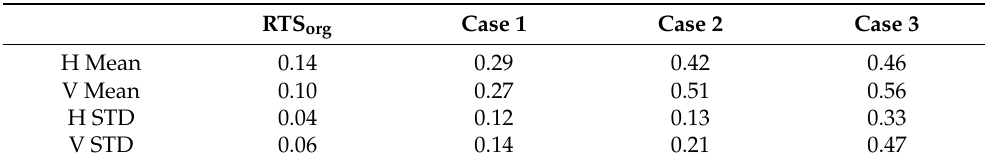
Table 3. Statistics of horizontal and vertical positioning errors (ONS1, 28 September–2 October 2022 unit: